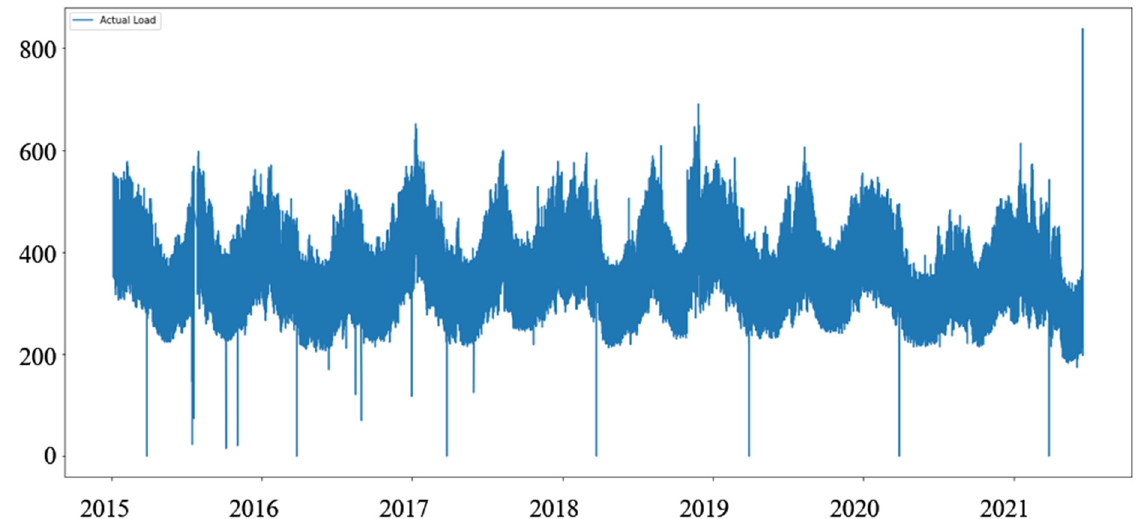
Figure 2. Hourly electricity consumption (load) for Montenegro.